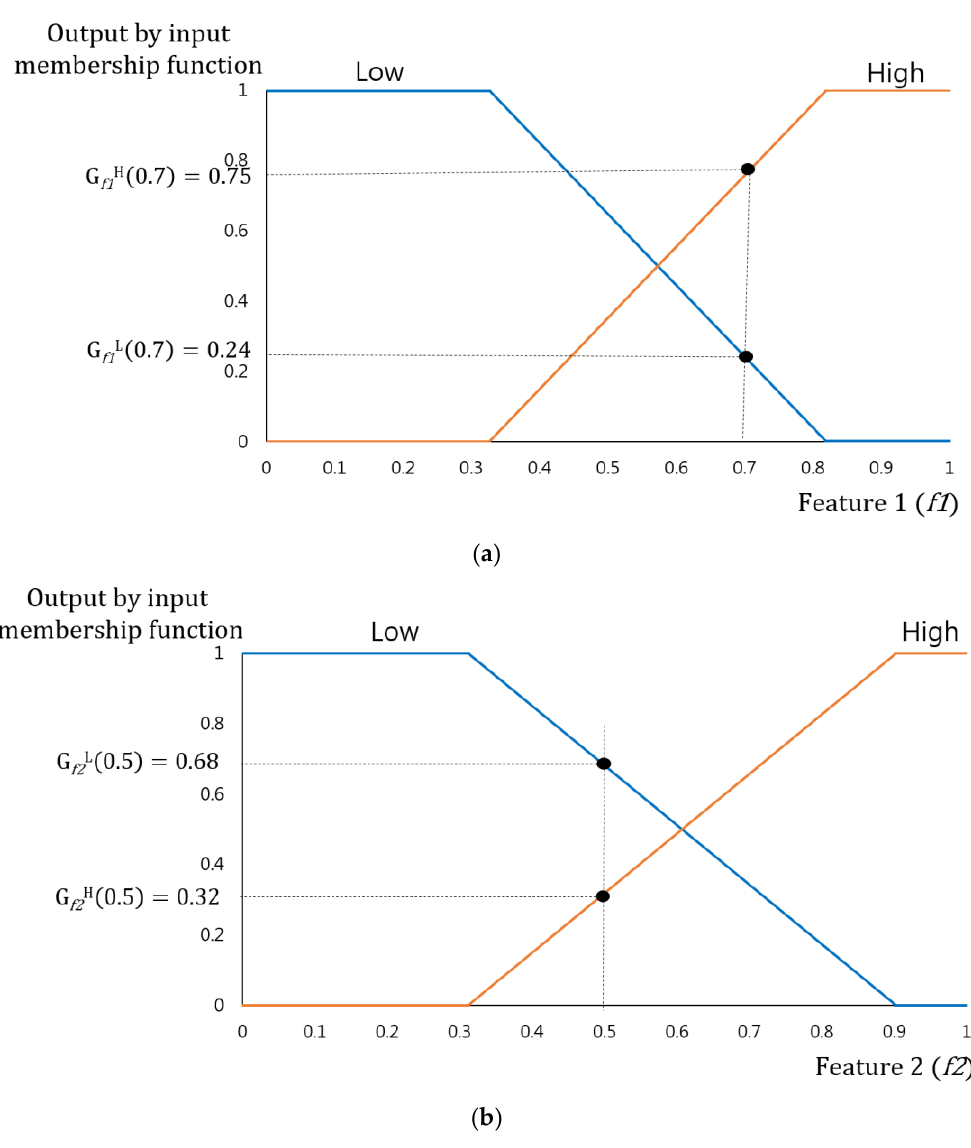
Figure 4. Example of obtaining outputs by input membership functions. ( a ) Output of “Feature 1”. ( b ) Output of “Feature 2”. Table 3. An example of the Inference Value produced by Min and Max rules with fuzzy rule table of Table 2a. Feature 1